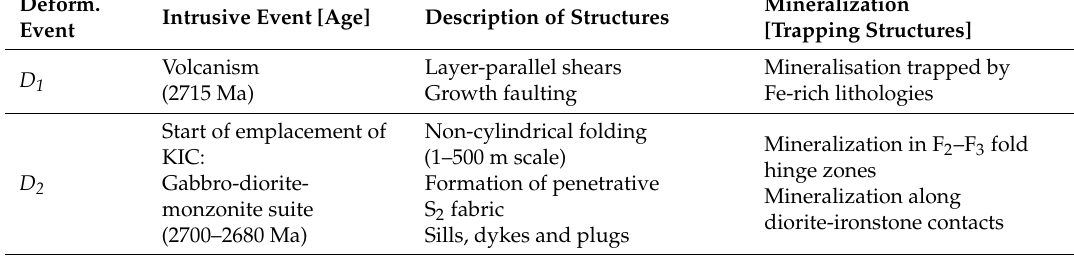
Table 1. Summary of deformation and intrusive events that affect the Kukuluma terrain. Listed age estimates are based on [25,28,29]. Mineralization occurs during D 7 events, and gold-bearing fluids are trapped in structures of D 1 to D 6 origin. Apy = arsenopyrite; Po = pyrrhotite; Py = pyrite.